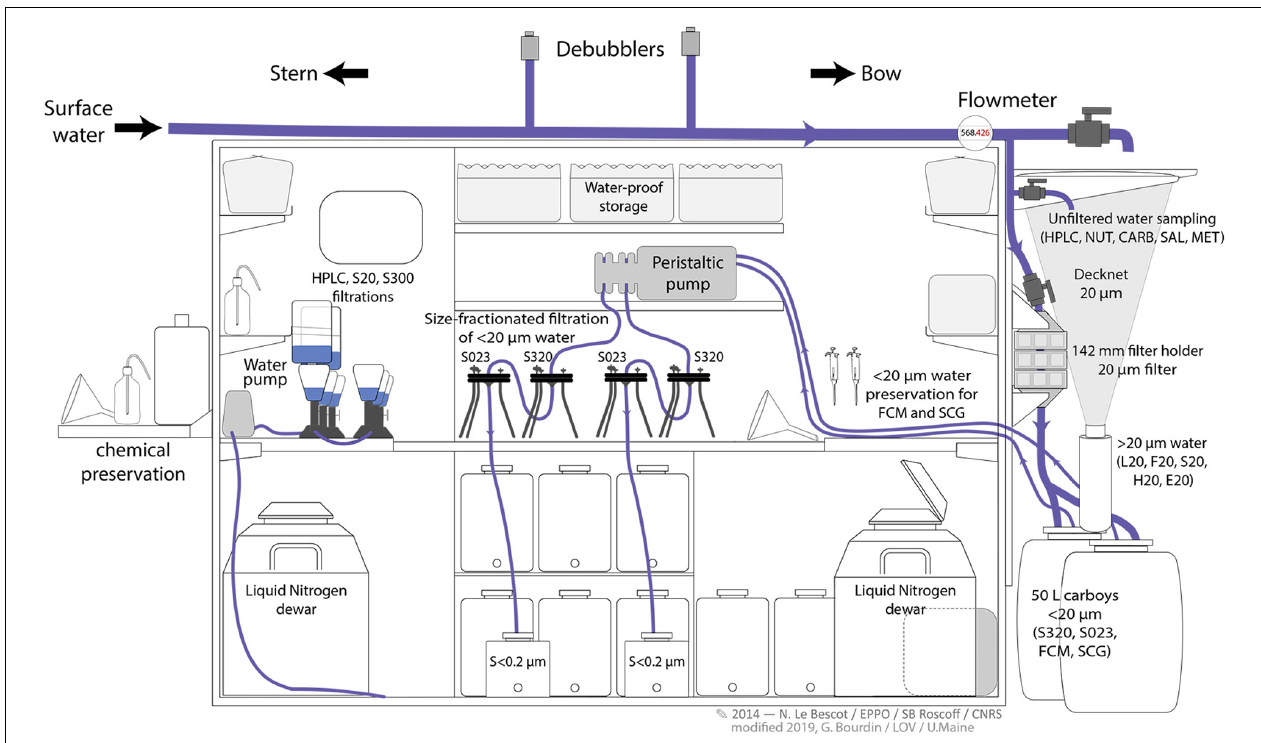
FIGURE 7 | Schematic diagram of the wetlab on board Tara, modified from Pesant et al. (2015). Note the optimization of the inner space and outer surfaces of the wetlab. Two filtration systems, one for filters of 142 mm, the second for filters of 25 and 47 mm diameters were installed inside the wetlab. The outer wall facing the bow was adapted for the distribution of the surface pumped water into the circuitry as described in Figure 6 . The wetlab wall oriented toward the stern was used for chemical preservation of